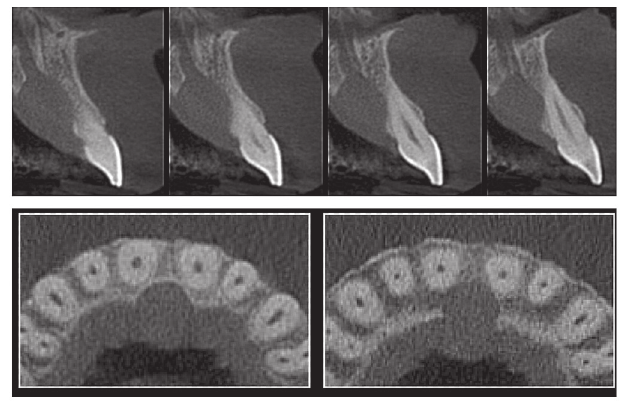
figurE 3 − Parasagittal and axial of CT sections showing well-defined hypodense area in continuity with the incisive canal, measuring 15 × 13 mm CT: computed tomography.